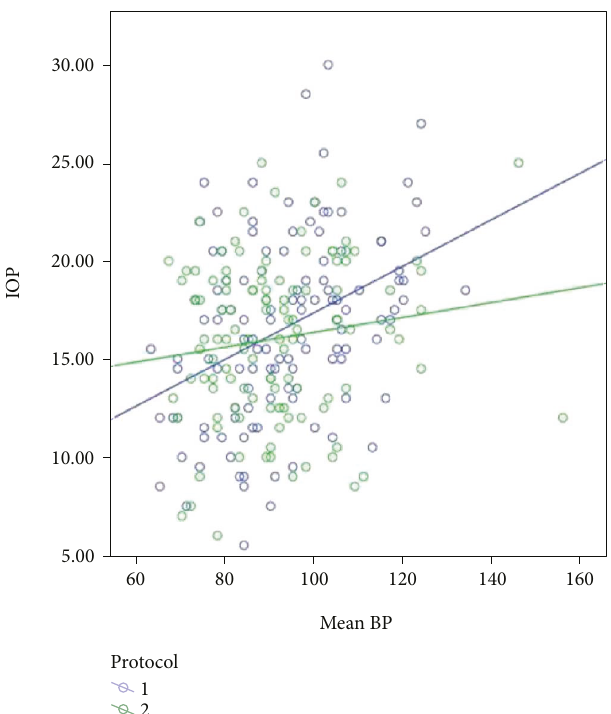
Figure 4: IOP versus MAP for each fl uid protocol. 1: liberal fl uid protocol. 2: restrictive fl uid